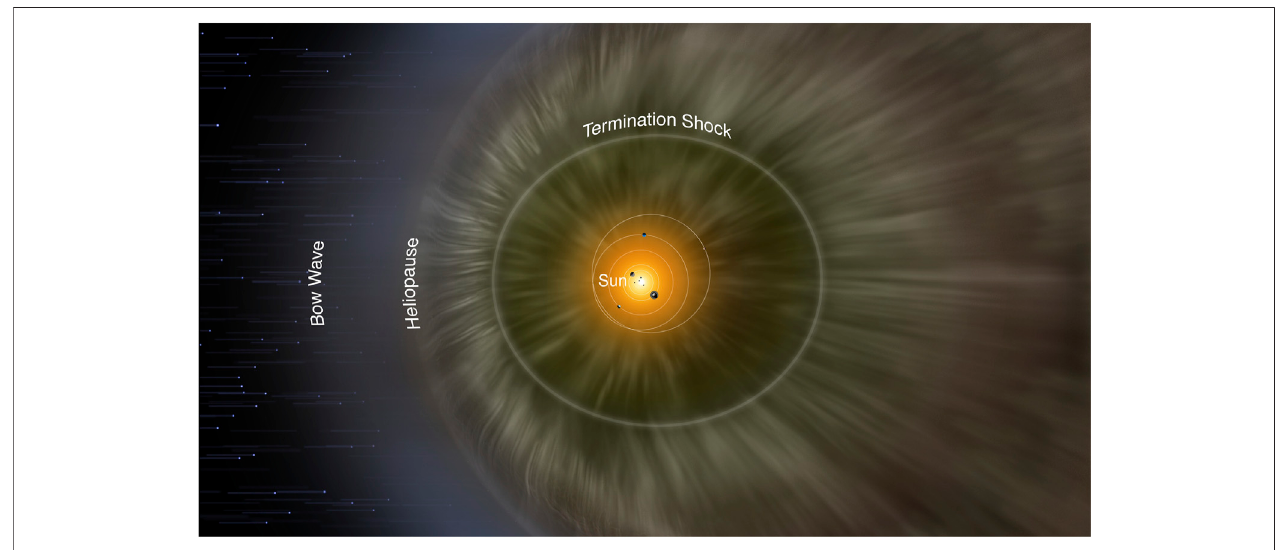
FIGURE 9 | A schematic of the heliosphere ’ s structure depicting the termination shock and heliopause. Image Credits: NASA/IBEX/Adler Planetarium.